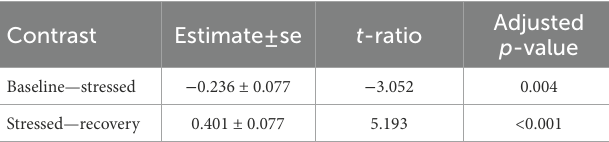
TABLE 1 Pairwise comparisons of sample types across all